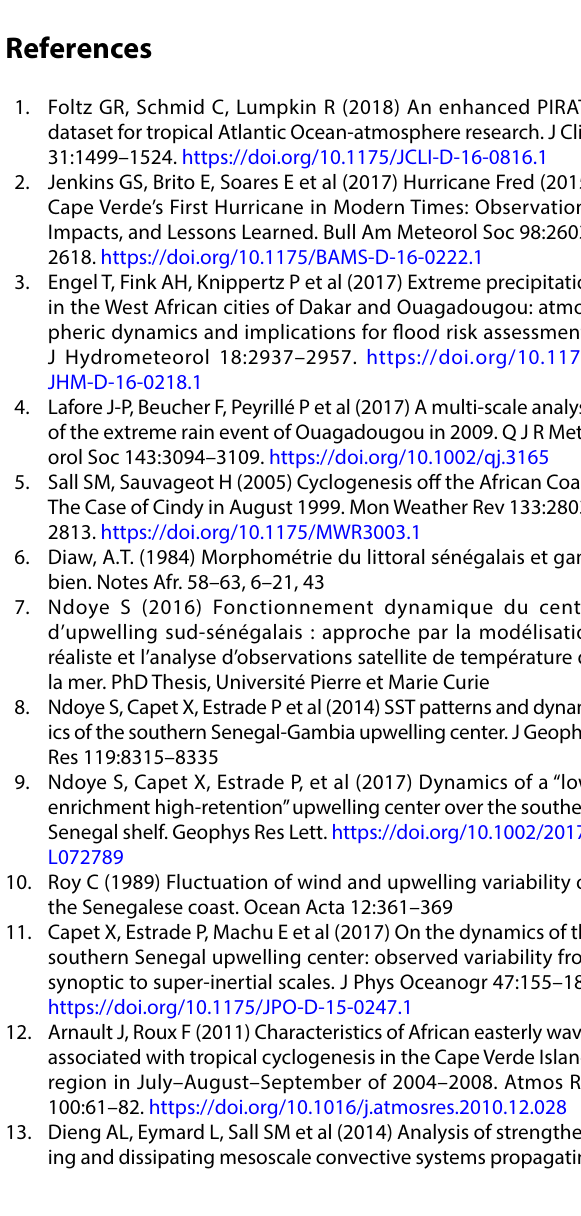
Fig. 9 Temporal series of the tide gauge data of Dakar station (longitude = −17.42°W, latitude = 14.67°N) from 1993 to